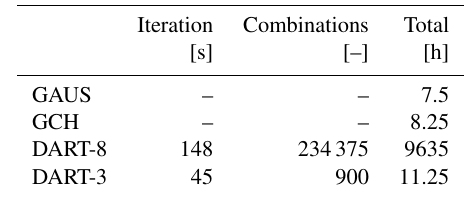
Table 4. Model training (DART) or tuning (GAUS and GCH) time using all 120 simulations and seven (4D ≤ x ≤ 10D) downstream distances. Iteration times are expressed as the mean over the first 100 iterations. DART’s total is a simple multiplication of iteration and